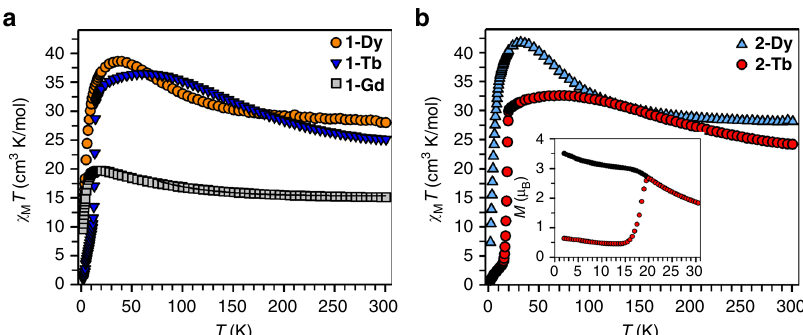
Fig. 2 Temperature dependence of the χ M T product for radical complexes. a Variable-temperature dc magnetic susceptibility data for restrained polycrystalline samples of 1-Dy (orange circles), 1-Tb (blue triangles), and 1-Gd (gray squares) collected under a 1 T applied dc fi eld. The black line represents a fi t to the data for 1-Gd , as discussed in the main text. b Variable-temperature dc magnetic susceptibility data for restrained polycrystalline samples of 2-Dy (pale blue triangles) and 2-Tb (red circles) collected under a 1 T applied dc fi eld. Inset: plot of magnetization vs. temperature for 2-Tb during fi eld-cooled (black circles) and zero- fi eld-cooled (red circles) measurements displaying the thermoremanent magnetization